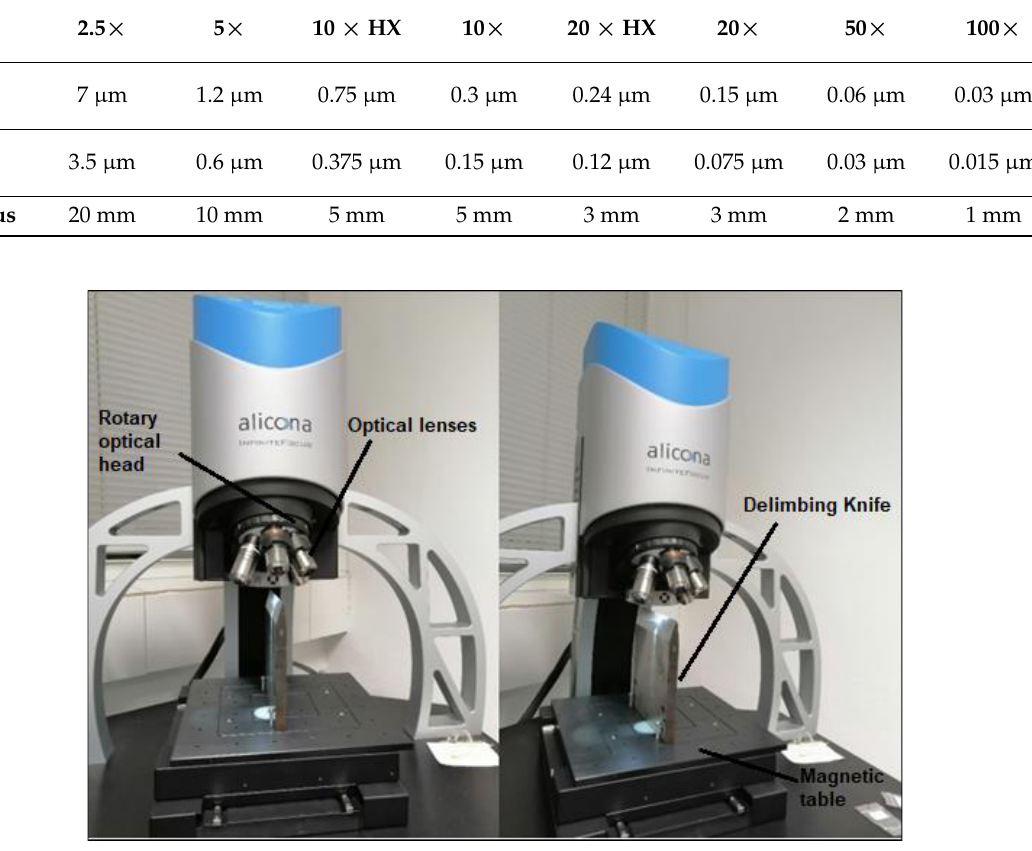
Figure 5. Alicona Infinity Focus — 3D optical method;